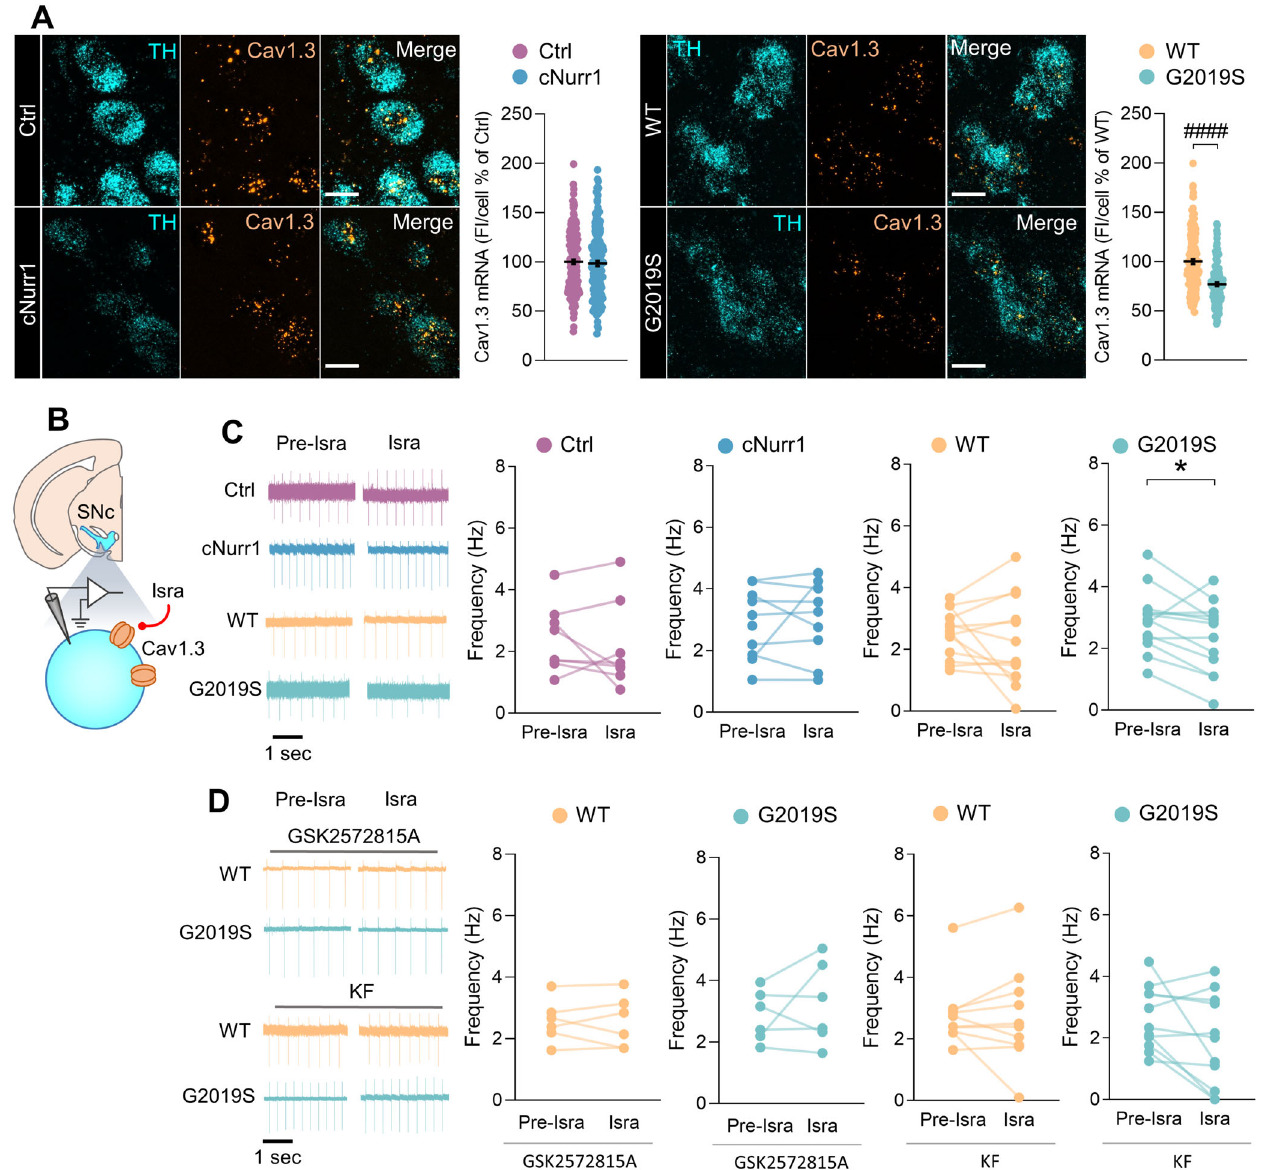
15 µm. Quanti fi cation of fl uorescence for CACNA1D mRNA in individual TH-containing cells in the SNc. n = 186, 185, 135, 126 neurons from N = 3 Ctrl, 3 cNurr1, 3 WT and 3 G2019S mice. #### P < 0.0001; Mann – Whitney U -test. B Schematic representation depicting the SNc and a DA neuron. Isradipine (Isra) was used to block Cav1.3 L-type channels. C , D Representative traces of pacemaker fi ring recorded in the cell-attached mode in SNc-DA neurons from Ctrl, cNurr1, WT and G2019S mice before (Pre-Isra) and during (Isra) the perfusion with isradipine (0.2 μ M) in control condition (aCSF, C ), in slices incubated with the LRRK2 kinase inhibitor GSK2578215A (1 μ M, D ) or with kaempferol (KF, 5 μ M, D ). Graphs show the fi ring frequency of individual SNc-DA neurons before (Pre-Isra) and during (Isra) the perfusion with Isradipine. Cells recorded in aCSF: n = 8, 9, 13, 13 neurons from N = 6 Ctrl, 8 cNurr1, 4 WT and 5 G2019S mice ( C ). * P < 0.05; Paired Student ’ s t -test. Cells recorded in GSK2578215A: n = 6 and 6 neurons from N = 2 WT and 4 G2019S mice. Cells recorded in kaempferol: n = 10 and 11 neurons from N = 5 WT and 5 G2019S mice ( D